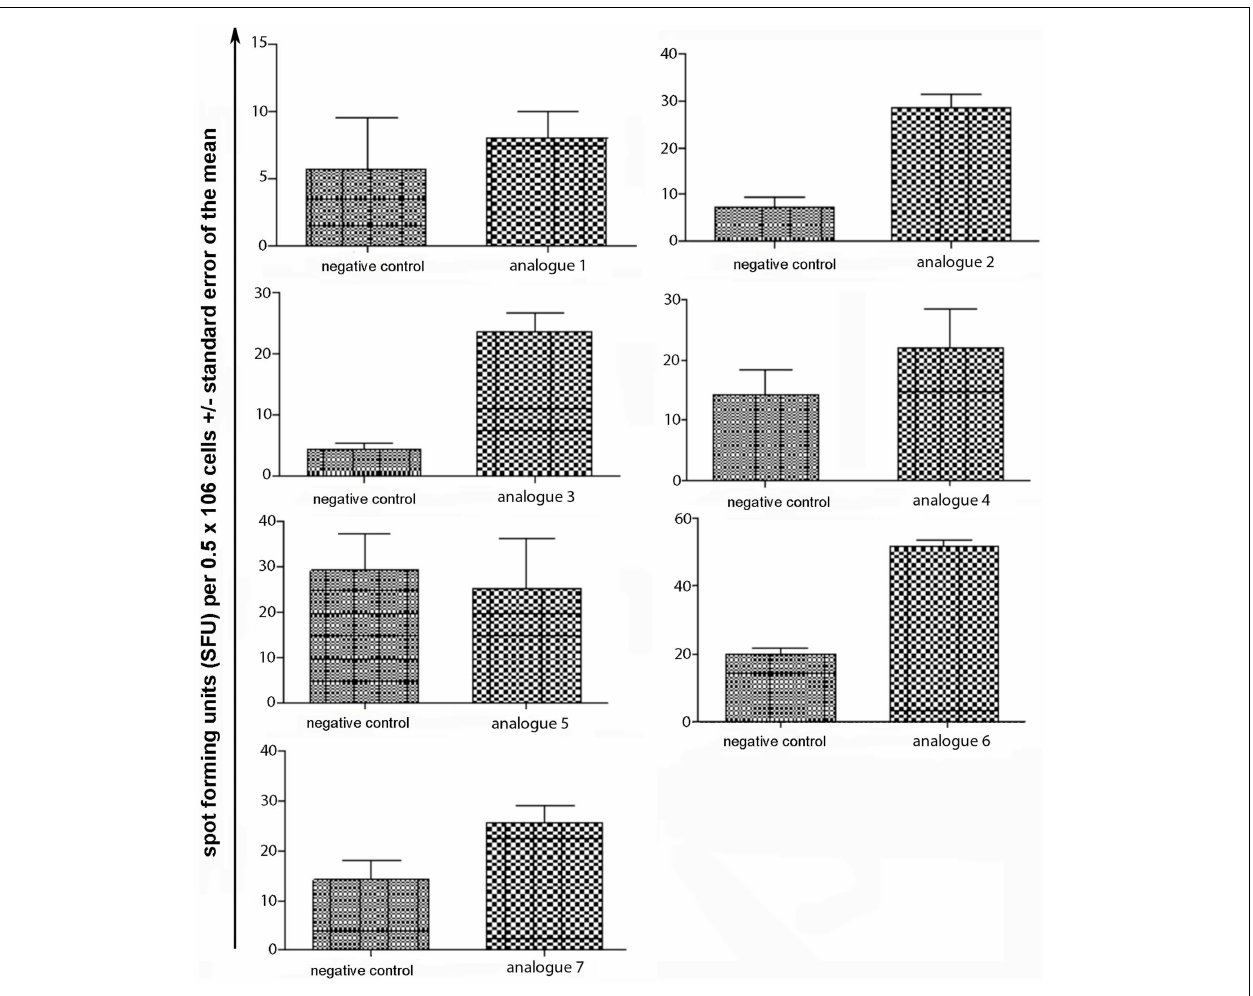
FIGURE 4 | IL-4 ELISpot assay of spleen cells from immunized mice . SJL/J mice were immunized using linear MBP 83–99 analogs conjugated to reduced mannan via (KG) 5 bridge (analogs 1–5 ) and cyclic MBP 83–99